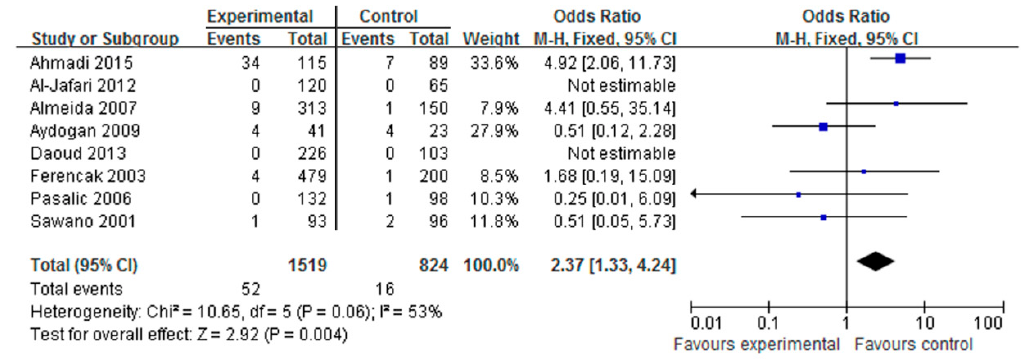
Figure 4. Forest plot of Ser447X XX genotype associated with CAD risk.